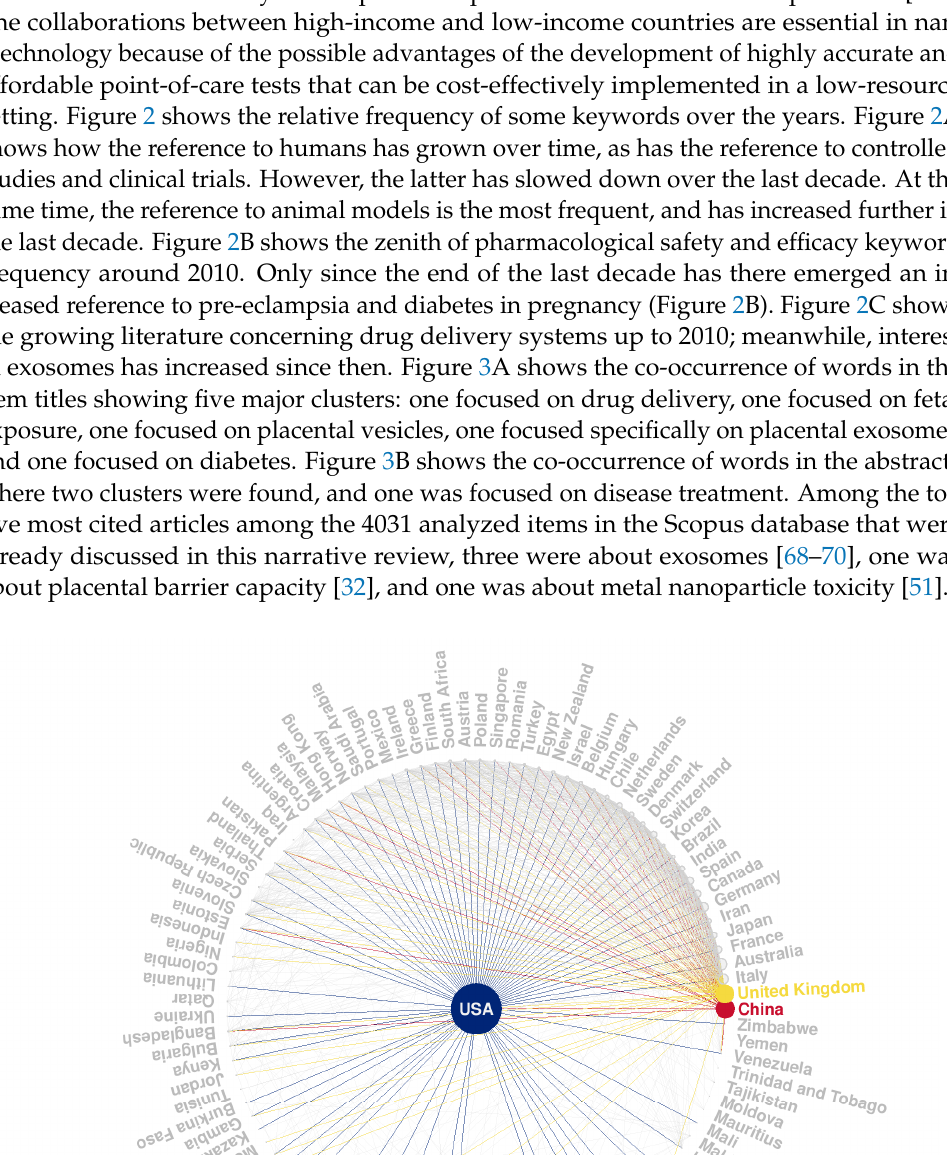
Figure 1. Panel ( A ): The plot shows the country collaboration network based on Scopus data. The vertex size is proportional to the number of collaborations, and the networks of the three most connected countries are highlighted. Panel ( B ): Spatial visualization of the degree of collaboration; blue and red colors correspond to the countries with more collaborations.